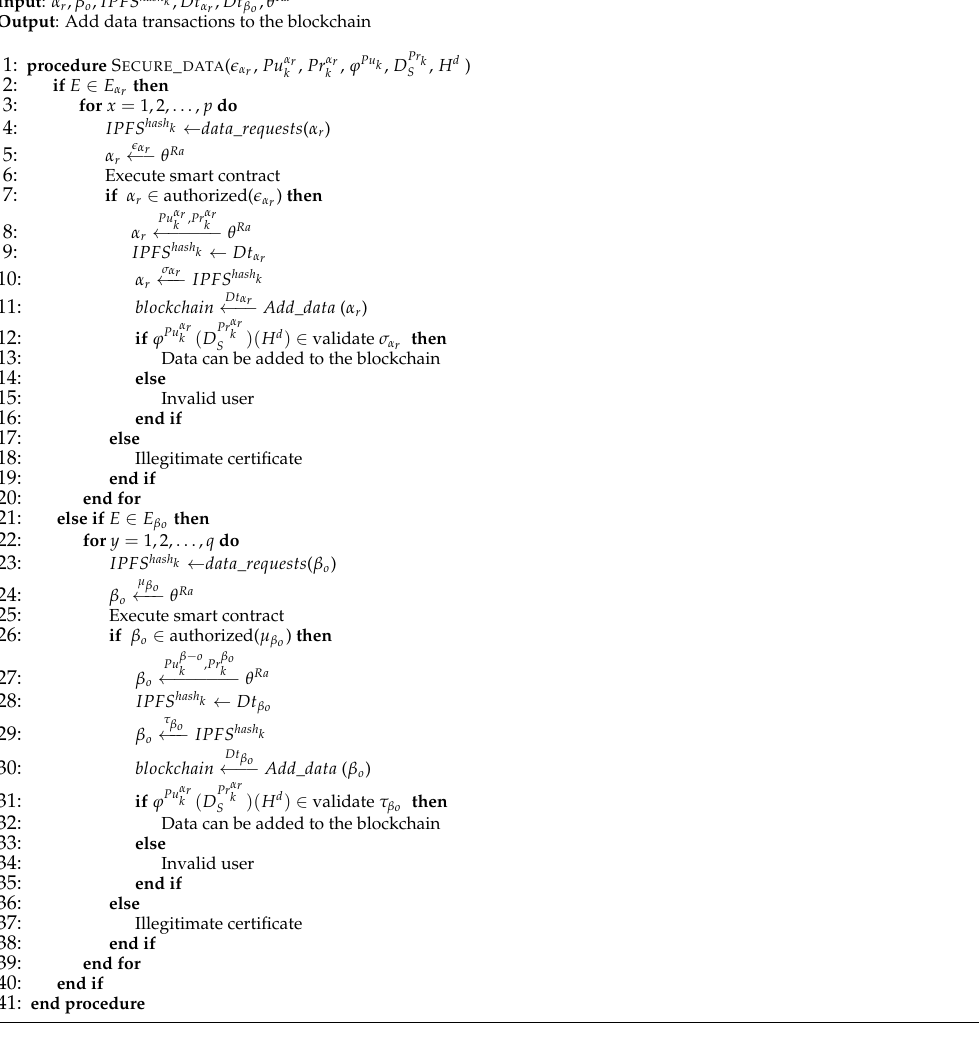
Algorithm 1 Blockchain-based algorithm to perform secure data transactions for